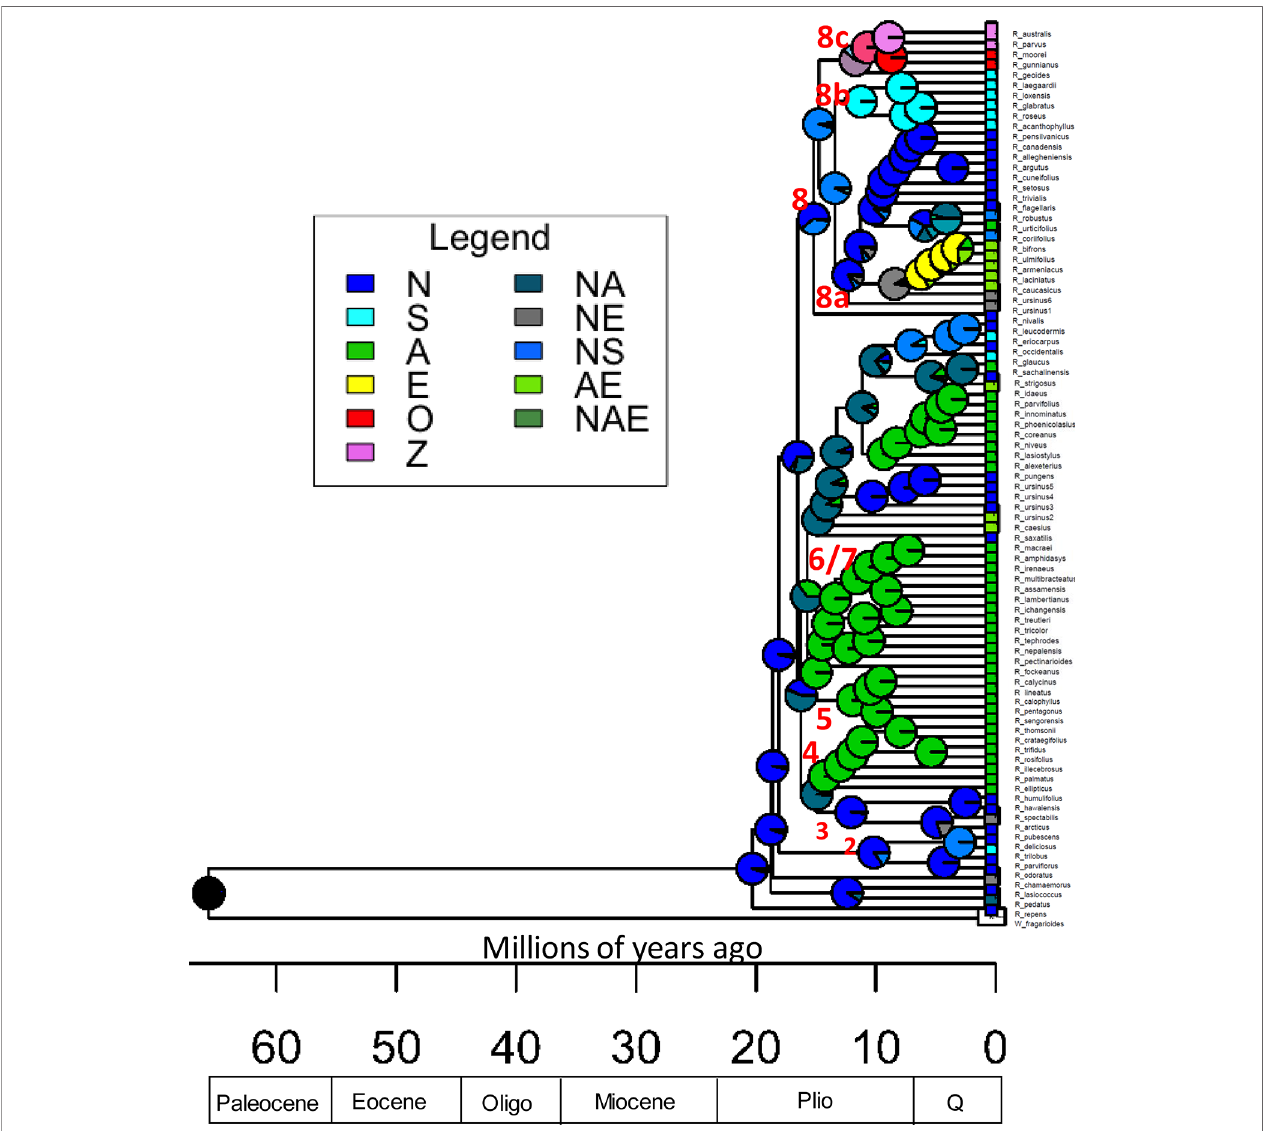
FIGURE 4 | Rubus ancestral range estimation using the DEC model for all taxa. Time scale is in millions of years. Pie charts represent relative probability of each area being the ancestral range. P, Pliocene; Q, Quaternary; N, North America (including Mexico and Guatemala); S, South America; A, Asia; E, Europe; O, Australia; Z, New Zealand. Combinations of letters indicate presence across multiple areas. Ancestral nodes for major groups are labelled